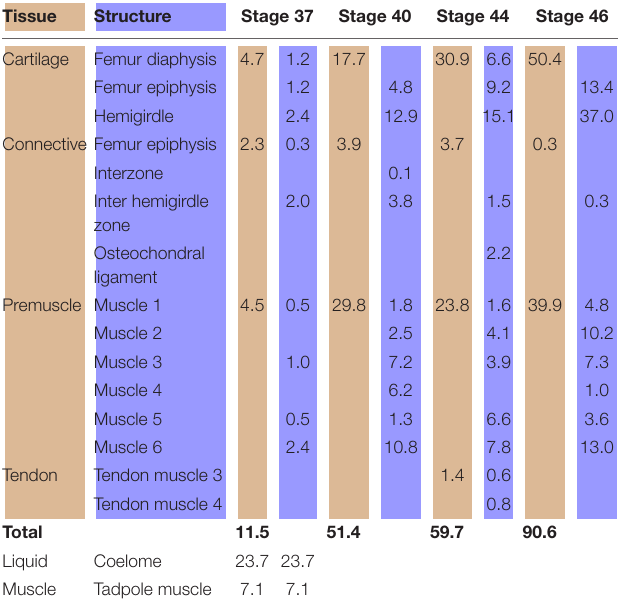
TABLE 1 | Tissues (light brown) and structures (light blue) percentages (%) in relation to the analyzed area ( Lisapsus limellum ). Tissue Structure Stage 37 Stage 40 Stage 44 Stage 46